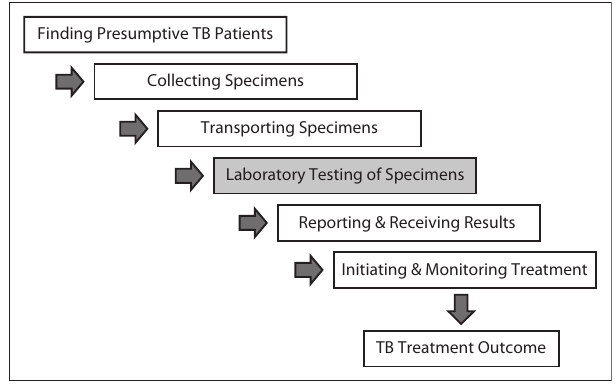
FIGURE 1: Key steps in the cascade from tuberculosis diagnosis to successful